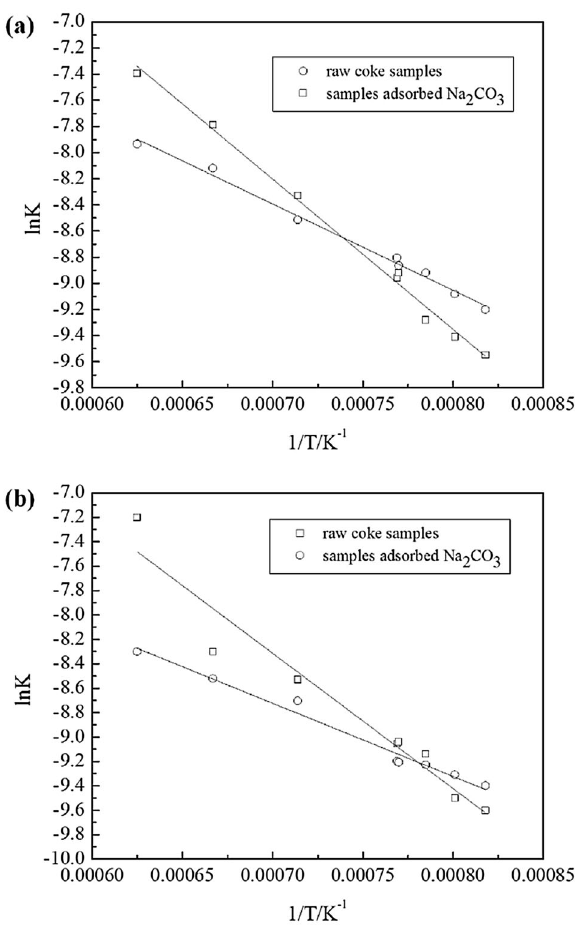
shrinking core model during gasification in CO 2 at different temperatures